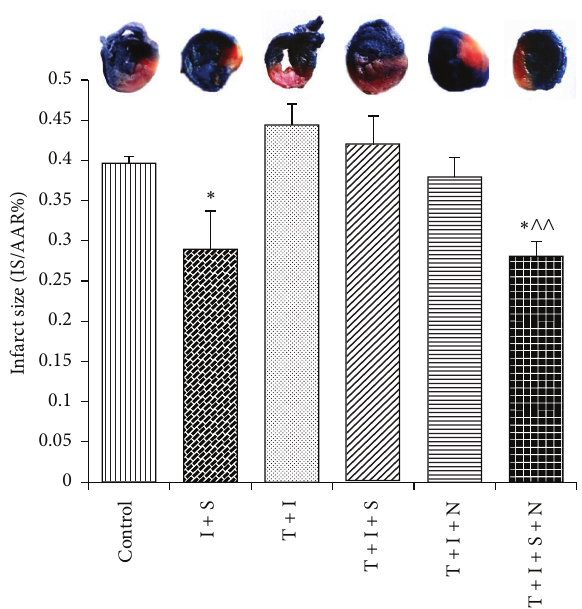
Figure 1: Comparison of IS/AAR% of rat hearts after 30 min ischemia followed by 90min reperfusion. Data was expressed as mean ± SEM ( 𝑛 = 6 per group). I, T, S, and N, respectively, stand for ischemia-reperfusion (I), Type 1 diabetes (T), sevoflurane (S), and N-Acetylcysteine (N); control: ischemia-reperfusion untreated group. ∗ 𝑃 < 0.05 compared with control group; ∧∧ 𝑃 < 0.01 compared with T + I group.